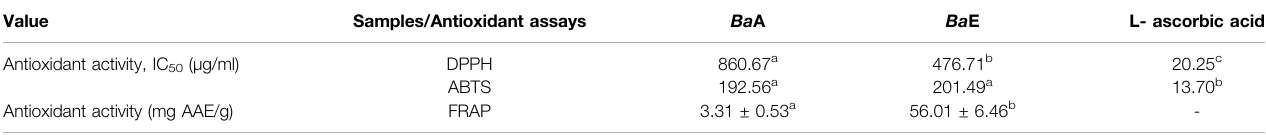
TABLE 3 | DPPH, ABTS and FRAP activities of Ba E and Ba A.